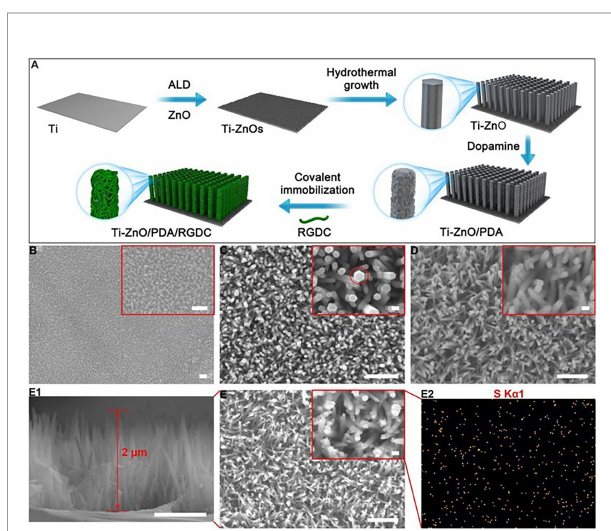
FIGURE 6 | (A) Schematic illustration of the fabrication process of the hybrid ZnO/PDA/RGDC NR arrays. Scanning electron microscopy (SEM) images of (B) Ti-ZnOs (scale bars = 100 nm), (C) Ti-ZnO, and (D) Ti-ZnO/PDA (116). Copyright © 2017 American Chemical Society. (E) SEM images of Ti-ZnO/PDA/ RGDC; (E1) cross-sectional image of Ti-ZnO/PDA/ RGDC; (E2) Elemental mapping of Ti-ZnO/PDA/RGDC [scale bars = 100 nm (inset fi gures = 1 m